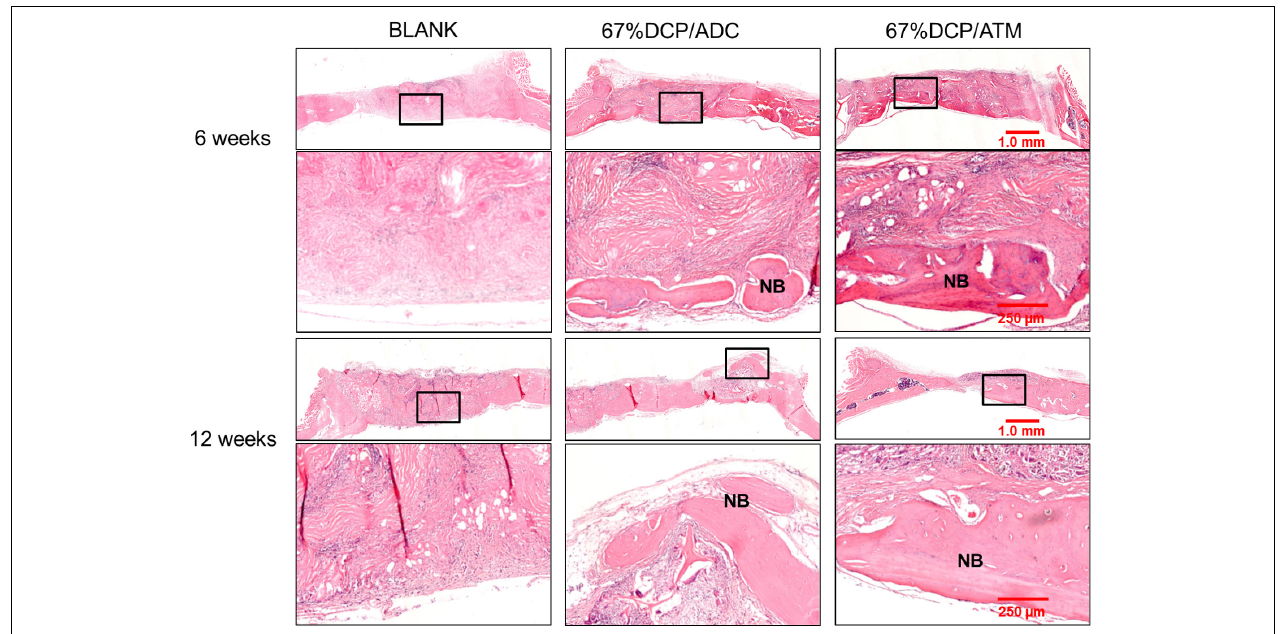
FIGURE 6 | Histology of calvarial defect sites via HE staining at 6 and 12 weeks post-implantation: the 1st and 3rd row represent the whole defect view of the three tested groups: BLANK, 67%DCP/ADC, and 67% DCP/ATM; the area in the black rectangles was shown in higher magnification in the 2nd and 4th row, respectively. The 2nd and 4th row represent the high magnification view of local bone formation in each group. NB, new